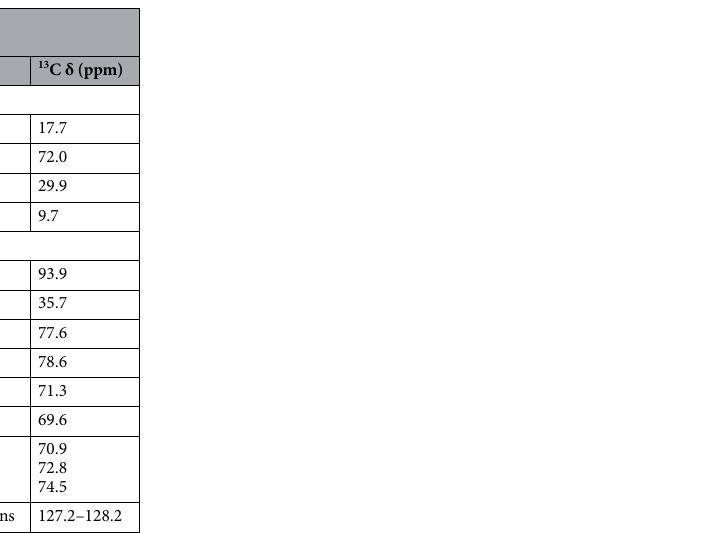
Table 5. Chemical carbon shifts for molecule 2C.